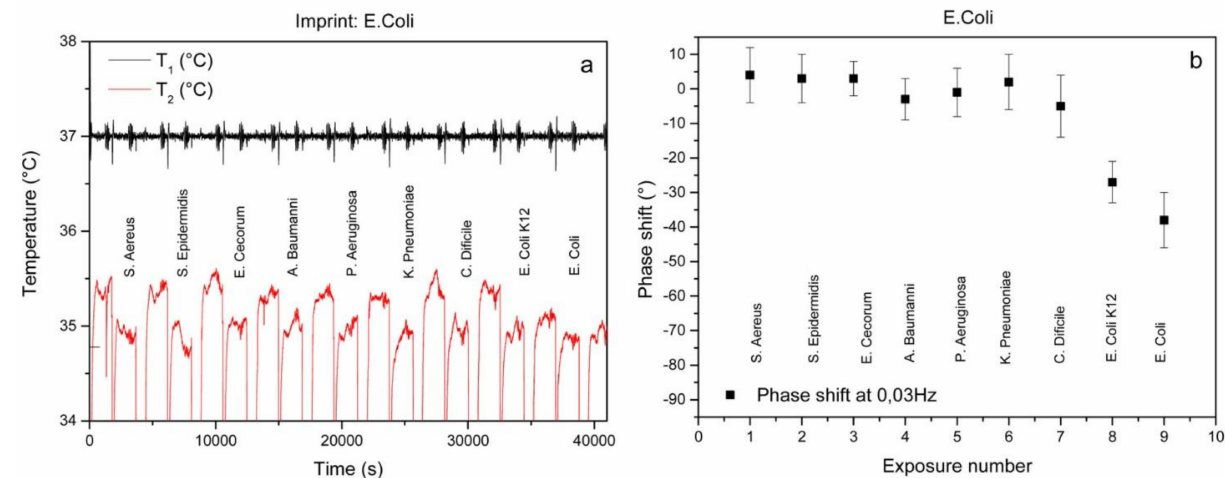
Figure 4. Cross-selectivity experiment showing the time-dependent temperature data for an E. coli SIP exposed to eight competitor bacteria and the target consecutively ( a ). The TWTA at 0.03 Hz is also shown ( b ). Both the temperature profile and TWTA data show some degree of cross-selectivity between the two E. coli strains